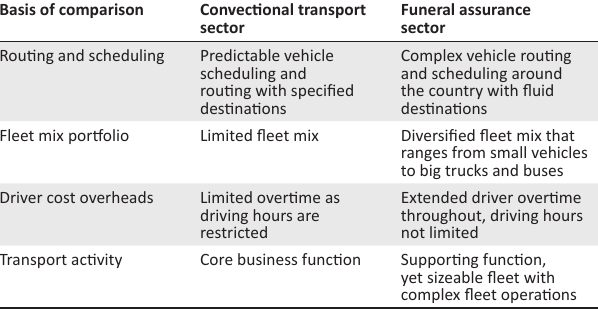
TABLE 1: Fleet operational characteristics between the conventional transport companies and the funeral assurance companies.